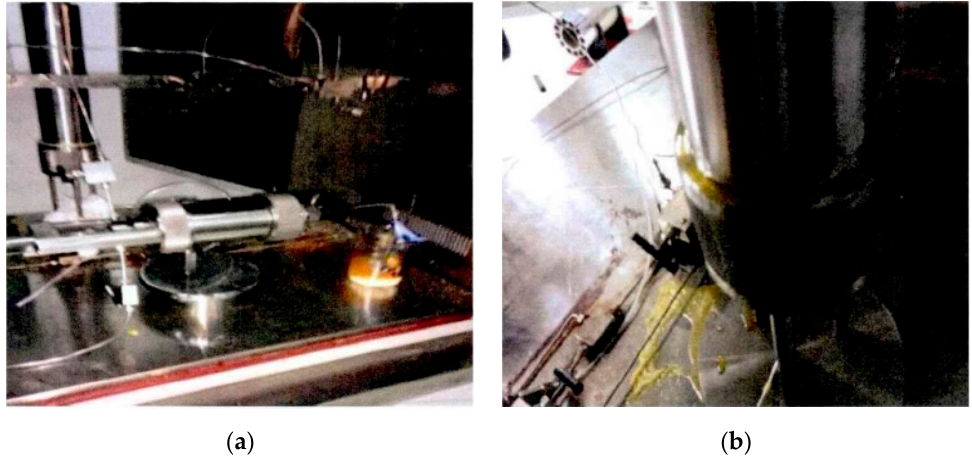
Figure 1. Problems during the experiment: ( a ) Liquid sulfur burning; ( b ) pipeline plugging by sulfur.